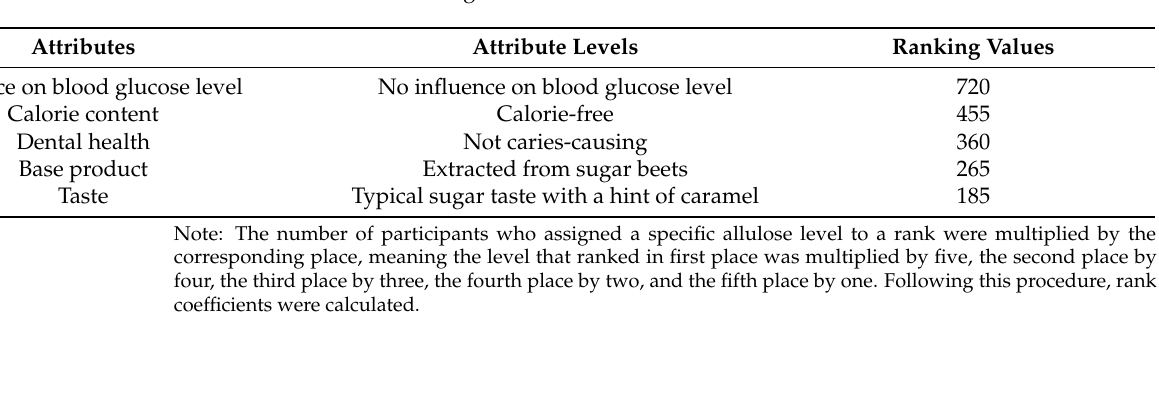
Table 5. Results of the ranking task of the allulose attribute